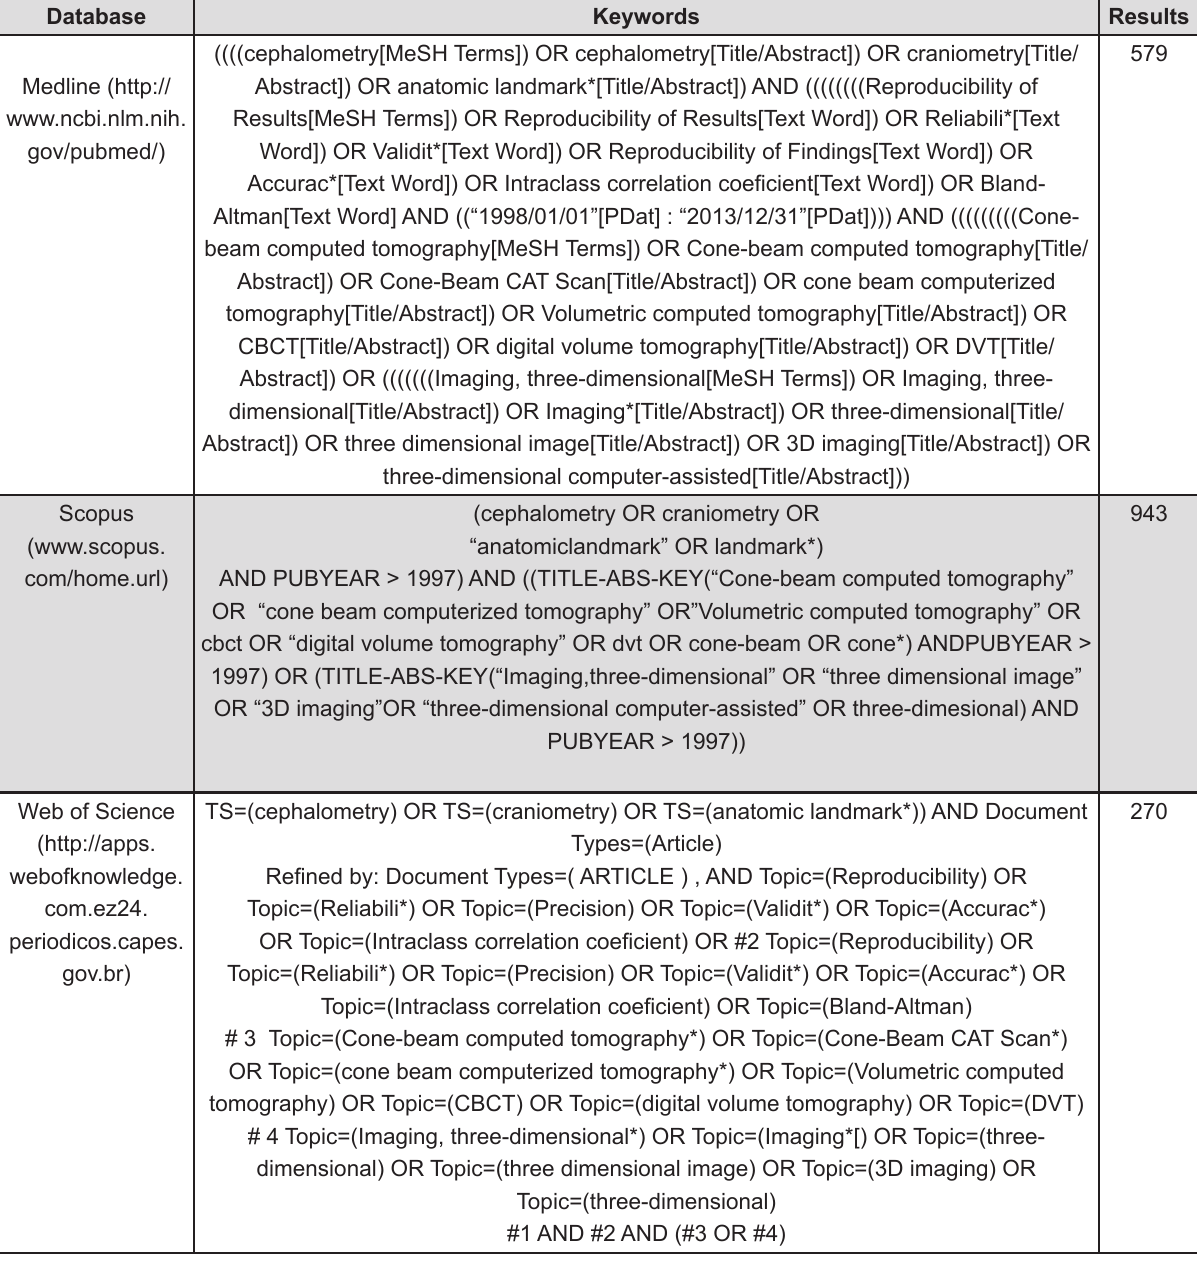
Figure 1- Relationship between the databases and search strategies used and the total number of articles